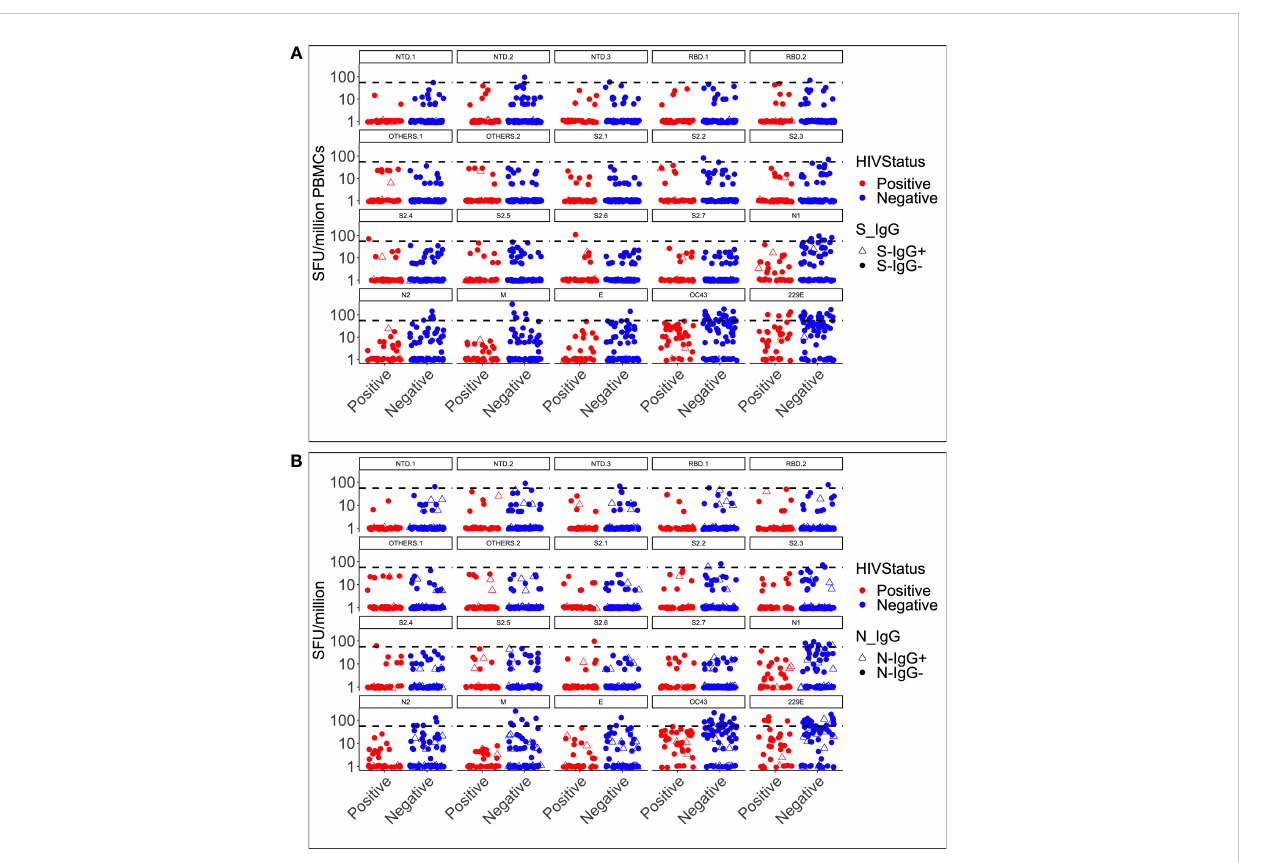
FIGURE 5 IFN- g cross-reactivity categorised HIV status and spike (A) and nucleoprotein (B) IgG response. Depicts the simultaneous induction of SARS-CoV-2- speci fi c IgG antibodies and IFN- g cross-reactive responses in 104 specimens with antibody and T-cell data against the spike (A) and the nucleoprotein (B) . The data is presented according to HIV serostatus, with HIV-positive individuals in red and HIV-negative individuals in blue. Open triangles represent participants with cross-reactive antibodies and IFN- g responses